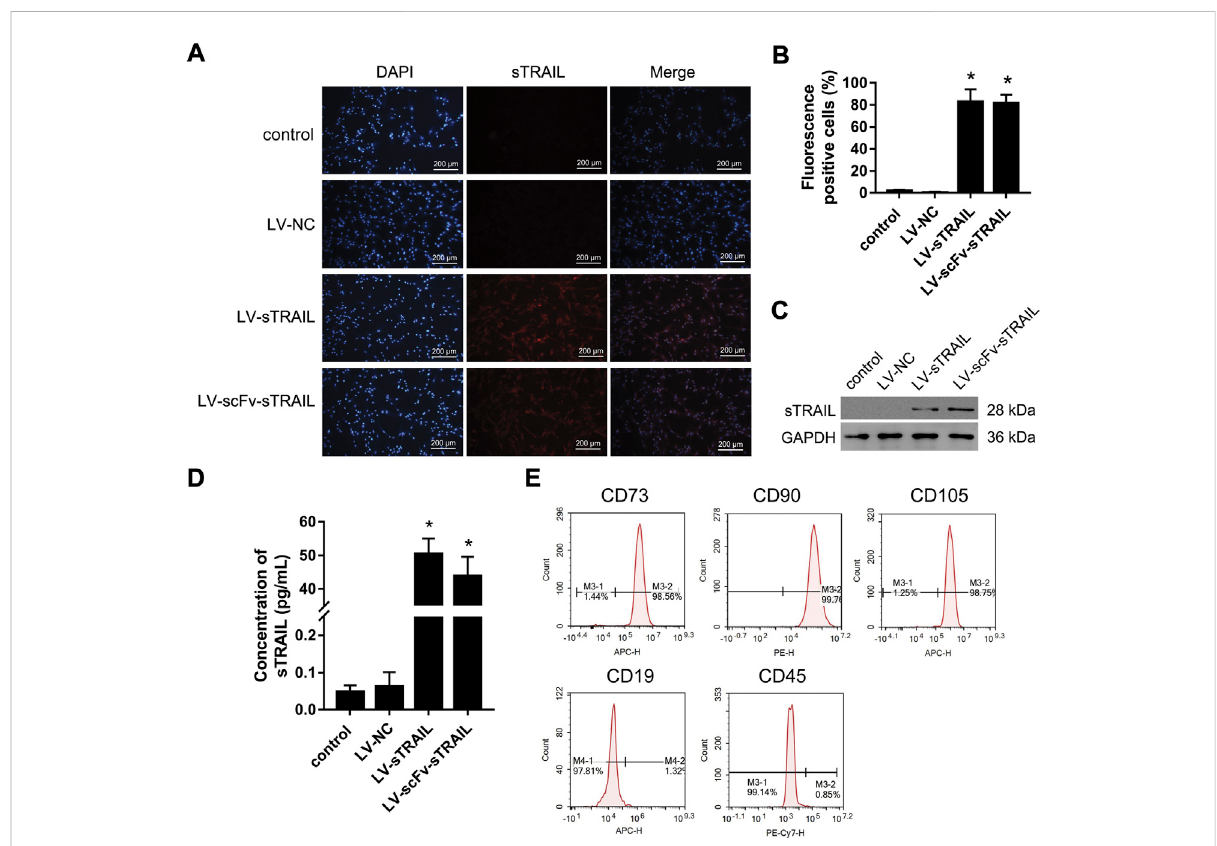
FIGURE 3 The effects of LV-scFv-sTRAIL infection on sTRAIL expression and biomarkers of hucMSCs. (A) The representative images of sTRAIL expression detected by immuno fl uorescence staining. (B) The quantitative data of sTRAIL positive cells. (C) Western blot detection of the expression of sTRAIL. (D) ELISA detection ofthecontent of sTRAIL intheculture supernatant. (E) Flow cytometric analysis ofhucMSCs speci fi cbiomarkers. Control group: normally cultured hucMSCs; LV-NC group: hucMSCs infected with empty plasmid lentivirus; LV-sTRAIL group: hucMSCs infected with lentivirus expressing sTRAIL; LV-scFv-sTRAIL group: hucMSCs infected with lentivirus expressing scFv-sTRAIL. Scale bar = 200 μ m n = 3, * p < 0.01 versus the LV-NC